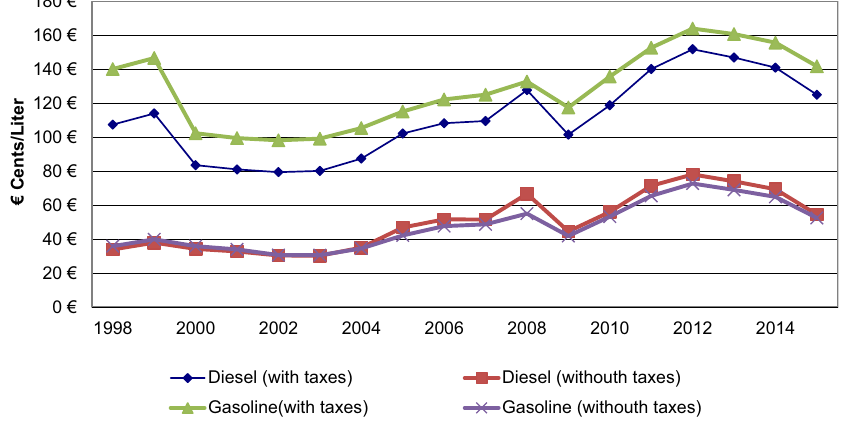
Fig. 3 Diesel and gasoline prices in main Western EU countries (Euros per liter, with and without